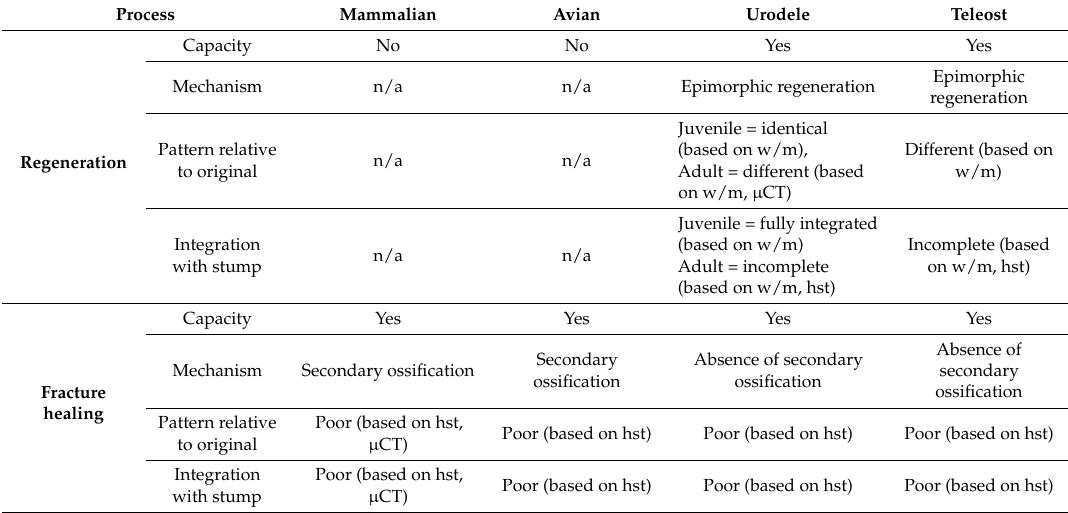
Table 1. Comparison of regenerative and fracture healing responses across vertebrate species in the lower jaw. n/a—not applicable; w/m—whole mount staining; µ CT—Micro computed tomography,